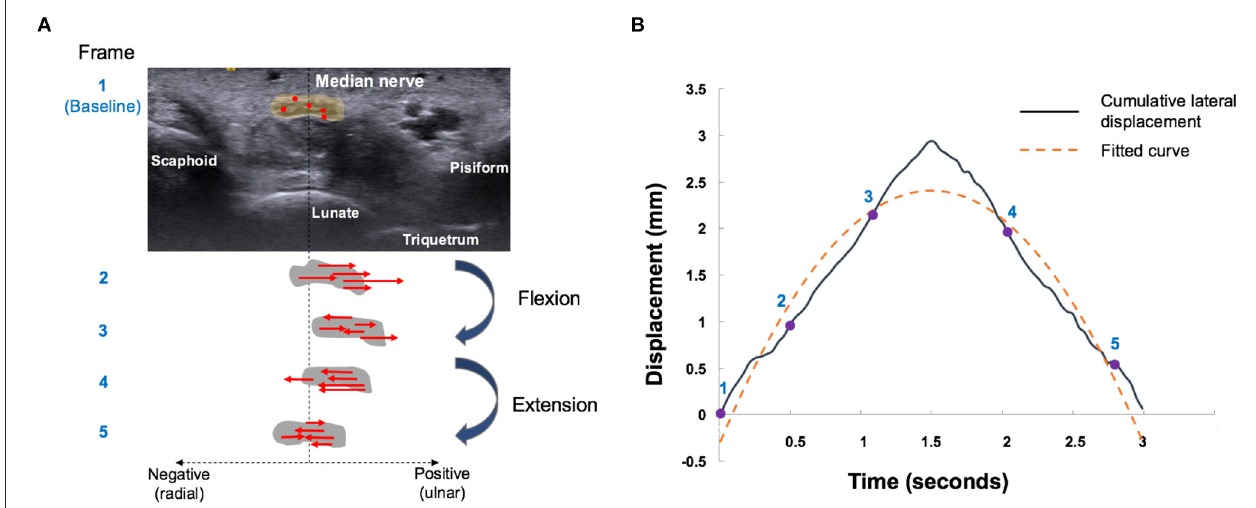
FIGURE 2 | Median nerve motion pattern during finger flexion and extension movements. (A) Schematic five-frame drawing of speckle tracking algorithm of the median nerve (gray circle). Red dots indicate the representative pixels and red arrows indicate the direction of radial (negative) or ulnar (positive) displacement of each pixel by automatically matching between temporally close frames. Sum displacement of all the pixels in the median nerve boundary was calculated as the lateral displacement. The median nerve movements were tracked by repeating the aforementioned operation. (B) Radial-ulnar displacements (black curves) of the median nerve versus time were obtained by cumulating the lateral displacement during a single flexion–extension cycle. The number labels on the curve represent the corresponding points on the graph. The dotted yellow curve represents the fitted curve obtained by the second-order polynomial function [f( x ) = a x 2 + b x + c]. The curvature of the fitted curve and R 2 were further